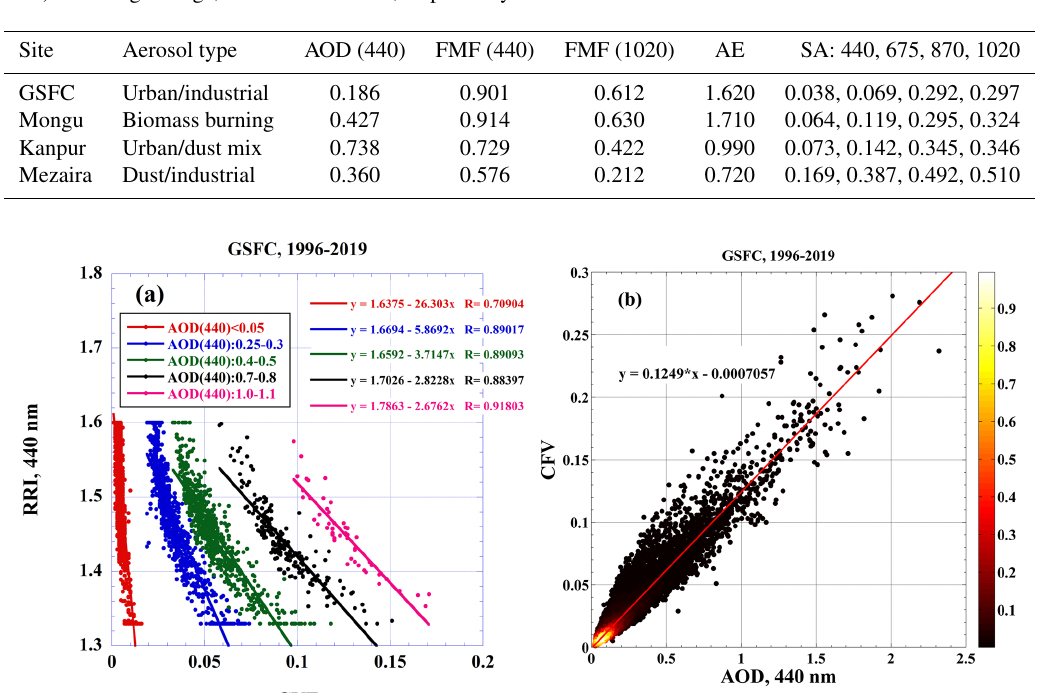
Table 18. Multiyear (1995–2019) averages of aerosol and surface characteristics at four AERONET sites selected for analysis of uncertainties in retrieved aerosol parameters. The abbreviations FMF, AE and SA stand for the fine-mode fraction of AOD, Angström exponent estimated for the (440–879) wavelength range, and surface albedo, respectively.